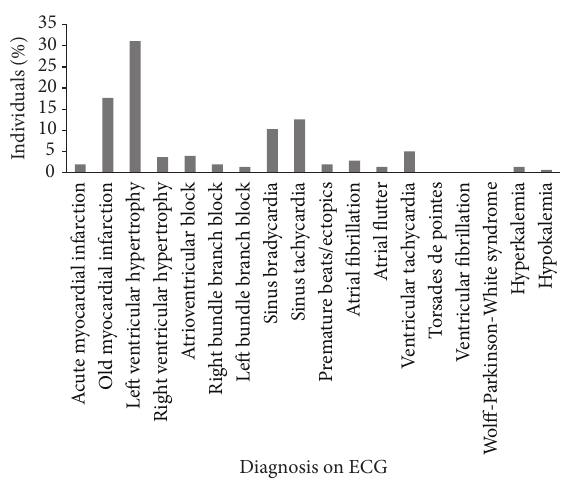
Figure 3: Distribution of abnormalities detected on